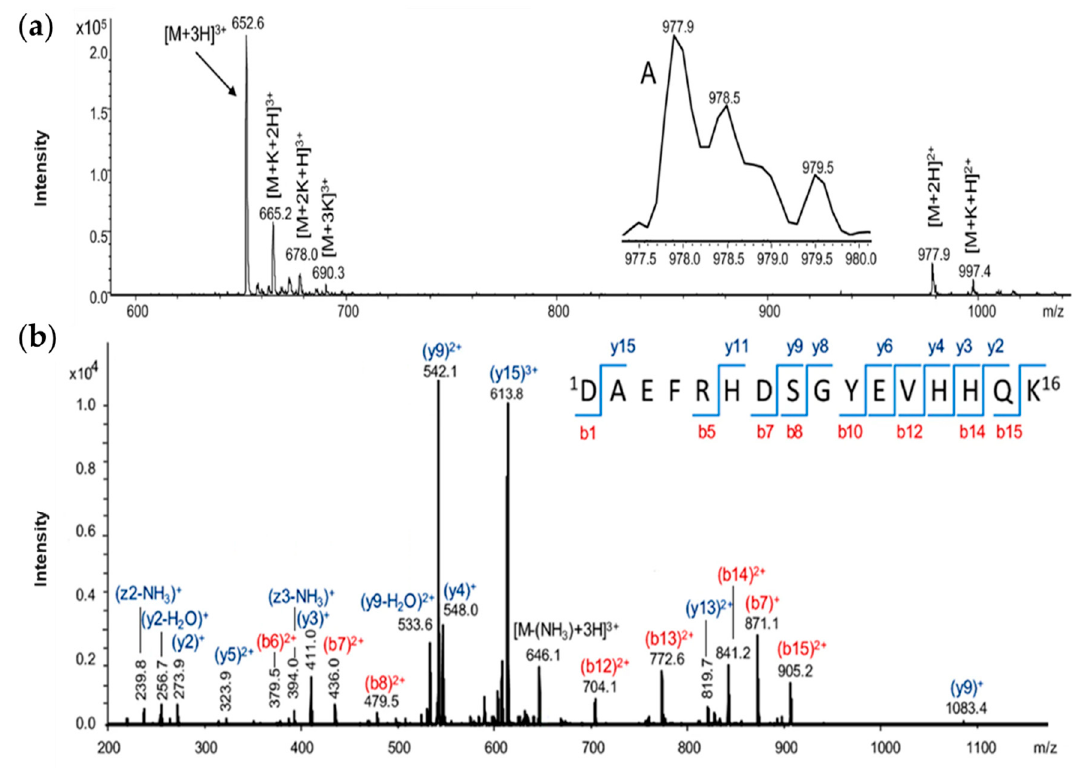
Figure 1. ( a ) Electrospray ionisation mass spectrometry (ESI-MS) analysis of A β (1–16) ; ( b ) MS/MS spectrum of [M + 3H] 3+ molecular ion.